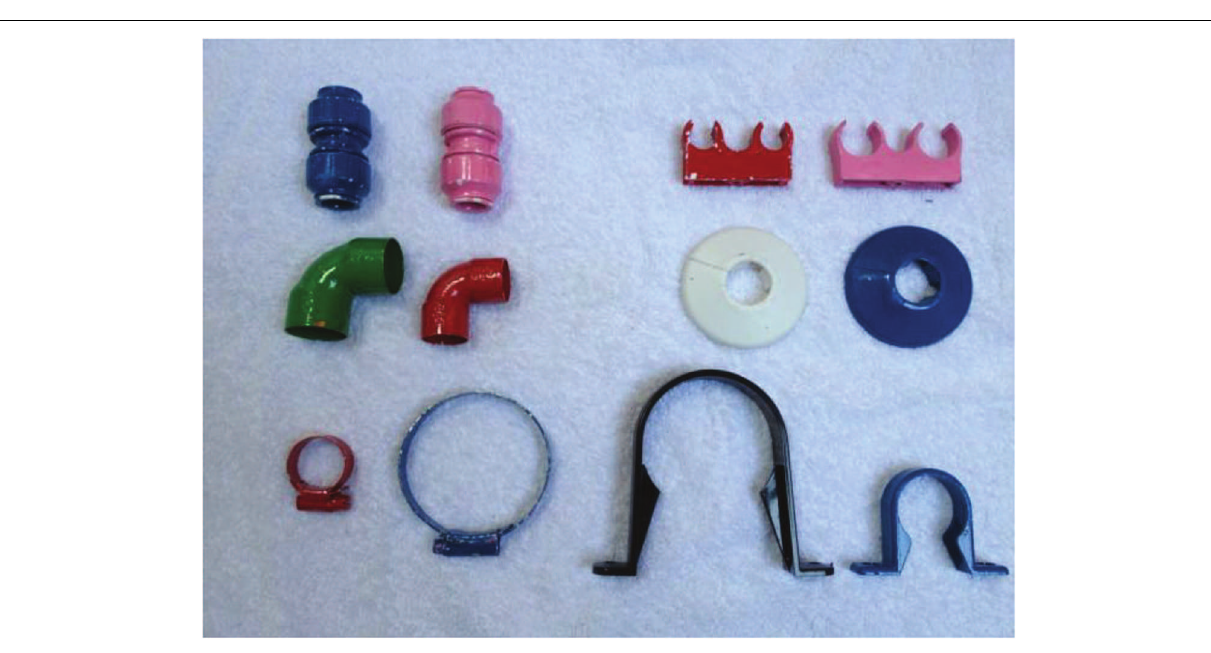
FIGURE 2 | Extension Array. From top, left to right (six pairs): blue connector and pink connector; red double pipe clip and pink double pipe clip; green elbow and red elbow; white pipe collar and blue pipe collar; red hose clip and blue hose clip; black pipe clip and blue pipe